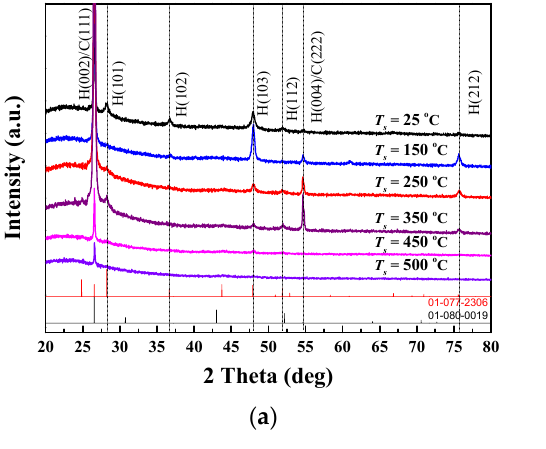
Figure 1. ( a ) XRD results of CdS thin films fabricated at various substrate temperatures, and ( b ) the details of the H(002)/C(111) peaks corresponding to the main diffraction plane in the XRD patterns. The peaks for the H(002)/C(111) plane representing the preferential growth orienta- tion were observed at a diffraction angle of 26.5° [21,22]. Relatively weak peaks corre-